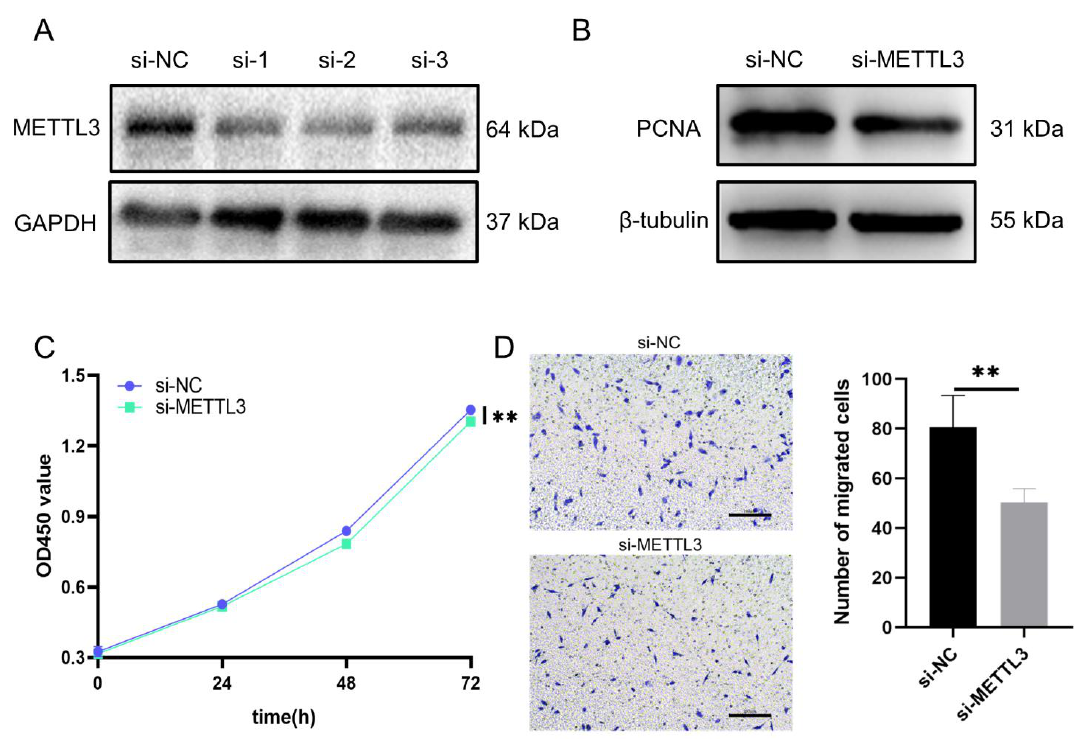
Figure 9. Regulatory role of METTL3 in proliferation and migration models of HCASMCs: ( A ) The protein levels of METTL3 were detected after transfection of siRNAs. ( B ) Knockdown of METTL3 could downregulate the proliferation-related protein PCNA. ( C ) CCK-8 analysis showed that the knockdown of METTL3 could inhibit the proliferation of HCASMCs. ( D ) The migration of HCASMCs was inhibited by knockdown of METTL3, as detected by transwell assay. ** p <